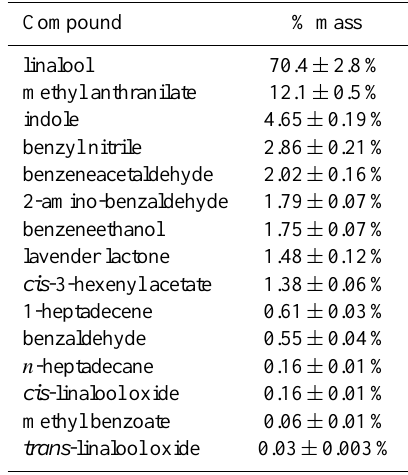
Table 6. Source profile ( ± Std. Dev.) for flowering emissions (non- monoterpene) from citrus